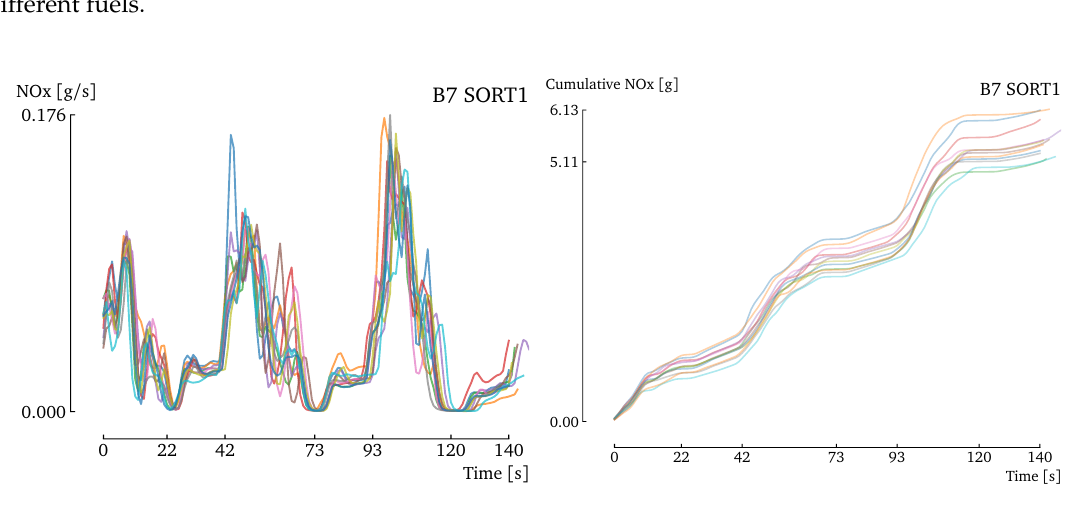
Figure 5. The NOx emission rate of the different SORT 1 runs (individual lines on the figure) are characterised by large increases during accelerations and stabilised low NOx emissions during idling. The cumulative NOx emissions measured during the different SORT 1 runs shows a good